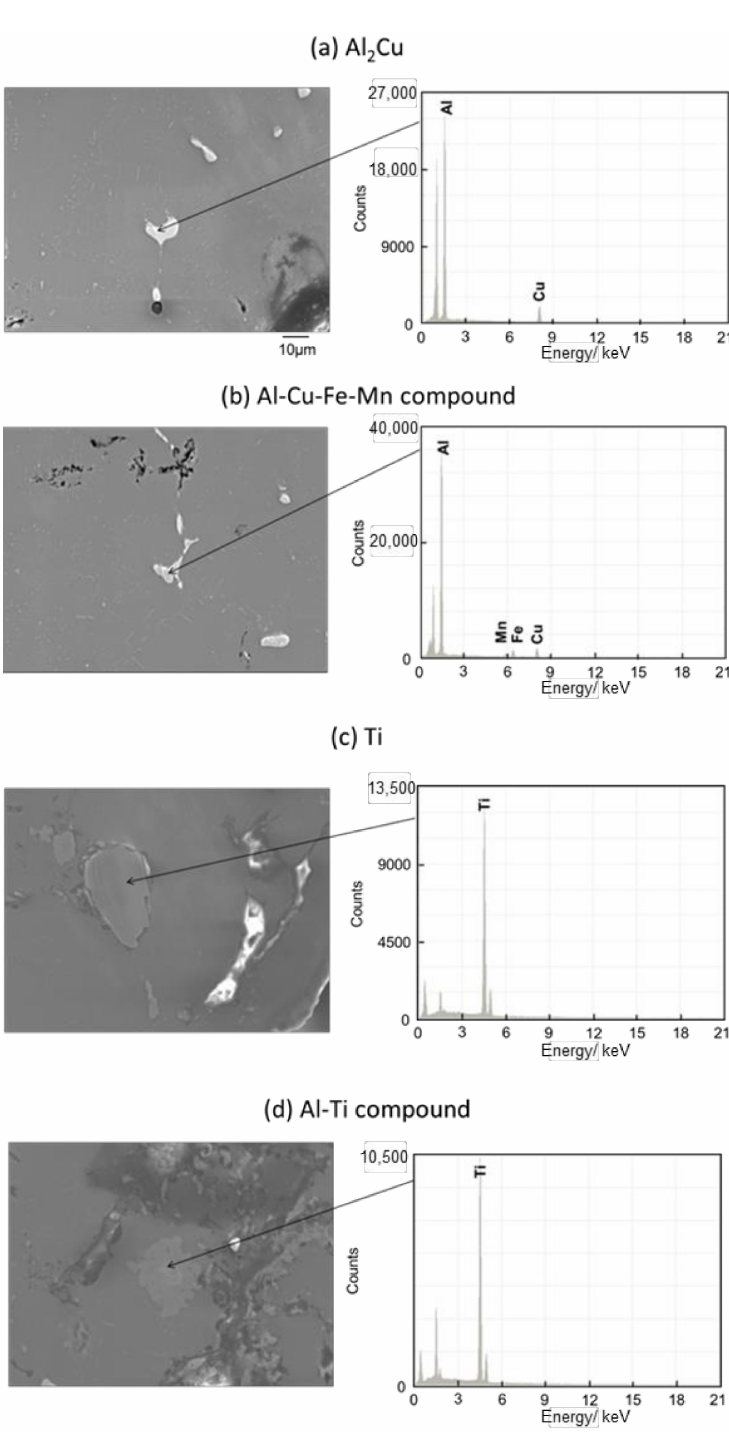
Figure 12. SEM images of intermetallic compounds and EDS analysis of the cell wall of